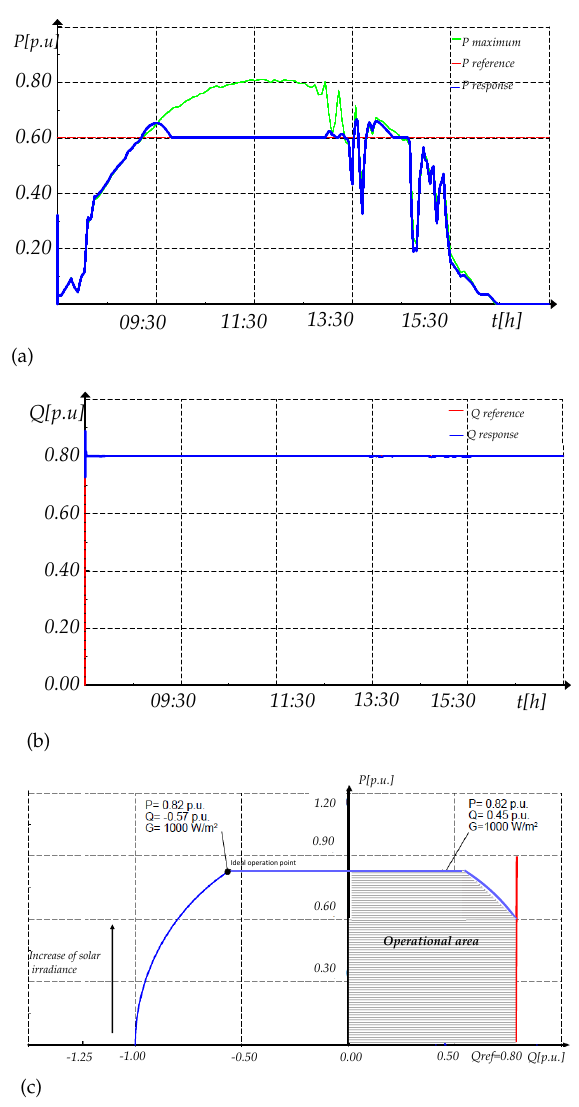
Figure 29. Power response with QPPC for M = 1.75 ( a ) Active power and ( b ) Reactive power, and ( c ) Operational